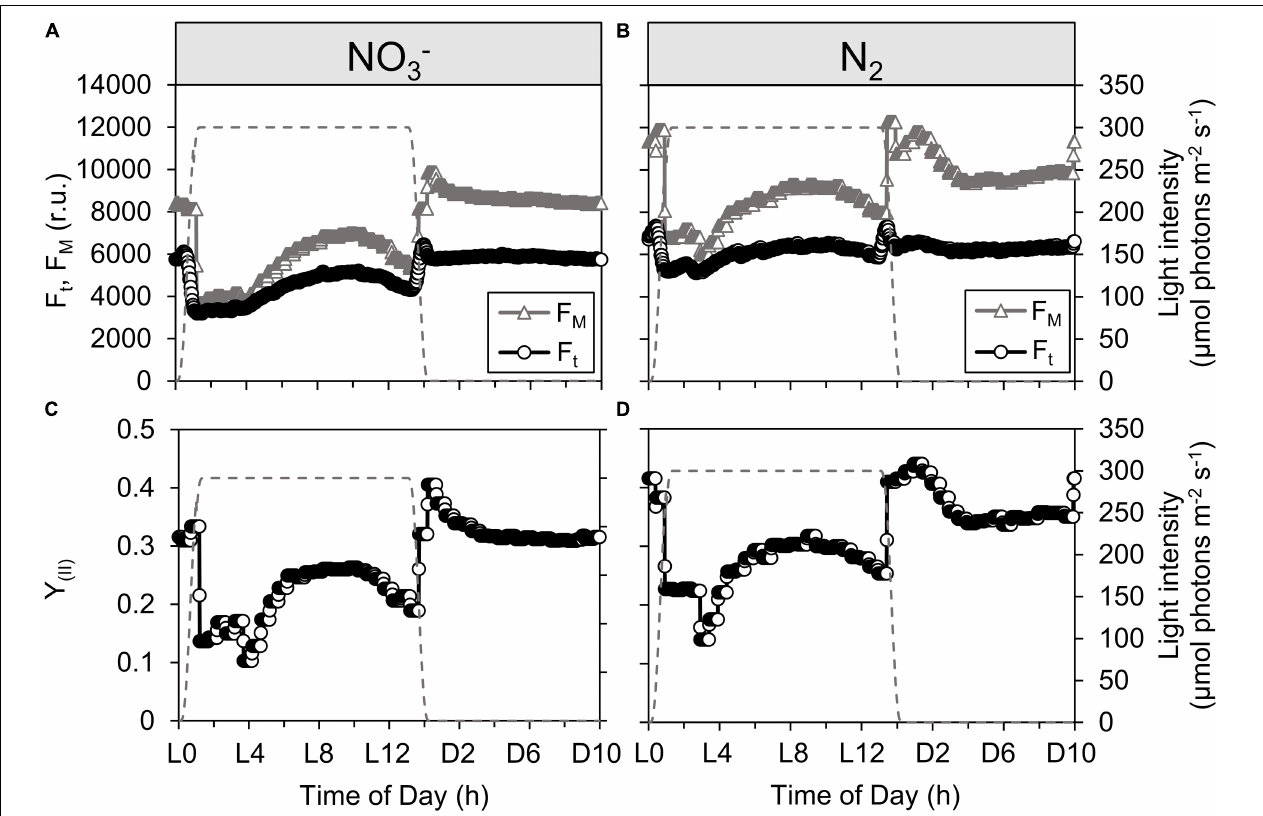
FIGURE 3 | Dynamics of steady-state fluorescence yield, F t [open circles; (A,B) ], maximal fluorescence yields, F M and F M (cid:48) [open triangles; (A,B) ] and quantum yield of PSII, Y II [open circles; (C,D) ] during Cyanothece cultivation in ASP 2 medium supplemented with NO 3 − (A,C) or under obligate diazotrophy (B,D) . The traces of F t , F M (or F M (cid:48) ) and Y II represent one typical record throughout a 24 h period acquired by the online pulse-amplitude modulated sensors of the photobioreactors. The gray dashed line represents the light profile over a 24 h